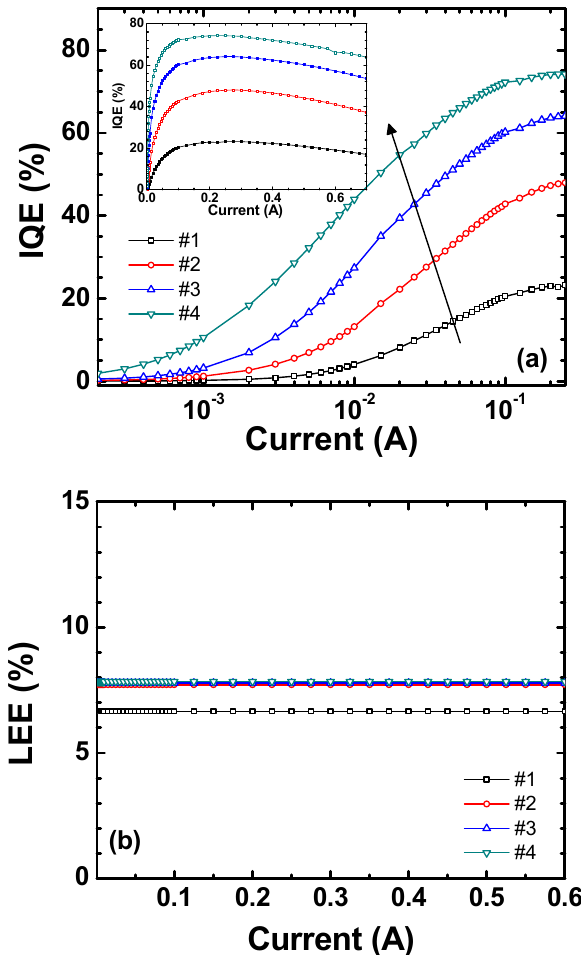
Figure 6. ( a ) The IQE characteristics on a semi-log scale from 200 μ A to 250 mA. The inset shows the IQE characteristics from 200 μ A to 700 mA on a linear scale. ( b ) The calculated LEE efficiencies. The analyses of I - V , n min , the PHEMOS pattern, the S value, the EL spectrum, λ p , the ER, and the IQE indicated that as the sample’s In composition, number of point defects, SRH recombination rate, carrier tunneling and overflow, and redshift all decreased; Δ E C , crystal quality, and F PZ all increased (as listed in Table 1). The improvement of the optoelectronic performances mentioned above increased the sample’s radiative recombination rate. However, it needs to be clarified which factor dominantly increased the radiative recombination rate at low currents. In this work, we propose that the dominant factor was spatially localized carriers caused by in-plane potential-energy fluctuation in QWs [18–30]. The possible reason for the potential-energy fluctuation could be the combined effects of inhomogeneous distribution of point defects, which was strongly affected by F PZ , and In composition: Schematic diagrams depicted in Figure 7 systematically and interactively describe the situation. There were inhomogeneously distributed point defects [40] caused by Ga/N vacancies [14,41] in QWs, which were not filled up by neighboring atoms with strong bonds between other atoms. This effect relaxed the neighboring atoms by increasing the lattice constant, which led to the bandgap energy near the point defect increasing [30,33]. Thus, in a site with accumulated defects, the crystal relaxation occurs and the bandgap energy near this site increased like a potential barrier (PB). Thus, a relatively defect-free potential “valley” was created between the accumulated defective sites. In these potential valleys, carriers were localized as depicted in Figure 7 [30]. Note that the number of defects were